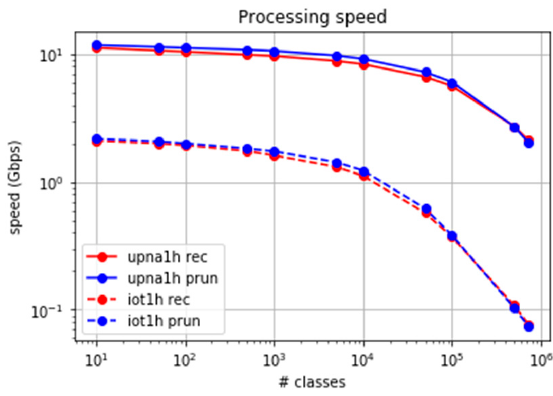
Figure 12. Packet processing speed for large sets of classes. ( a ) upna1h trace. ( b ) iot1h trace.